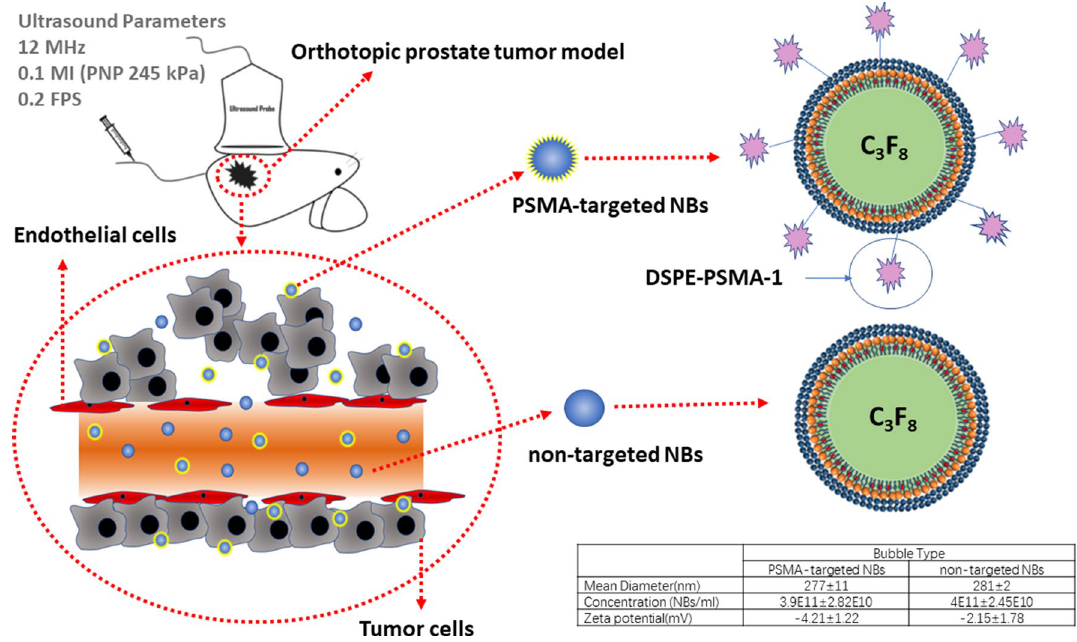
Figure 1. The schematic diagram of tumor model and PSMA-targeted NBs and non-targeted